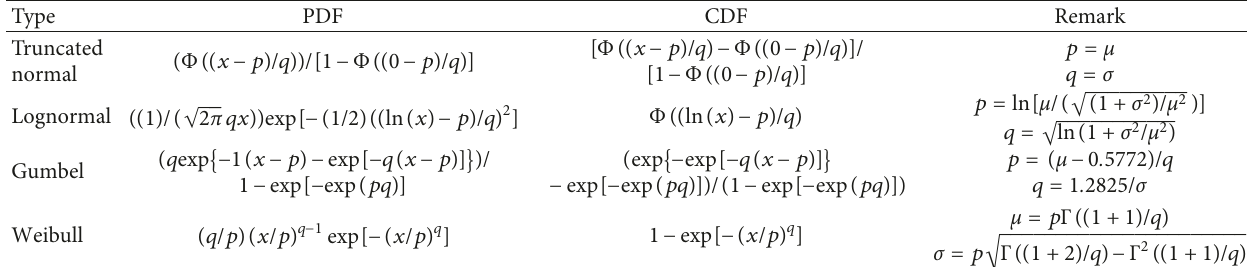
Figure 5: Probability plots of c and φ associated with ID and normal distributions. Table 3: Common probability distribution functions of parameter.